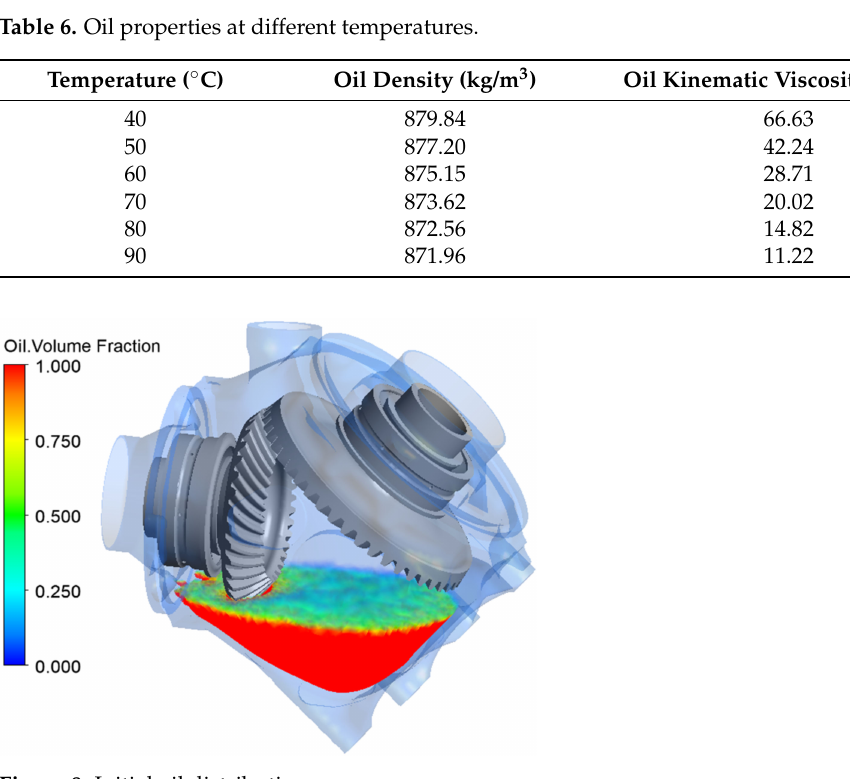
Figure 8. Initial oil